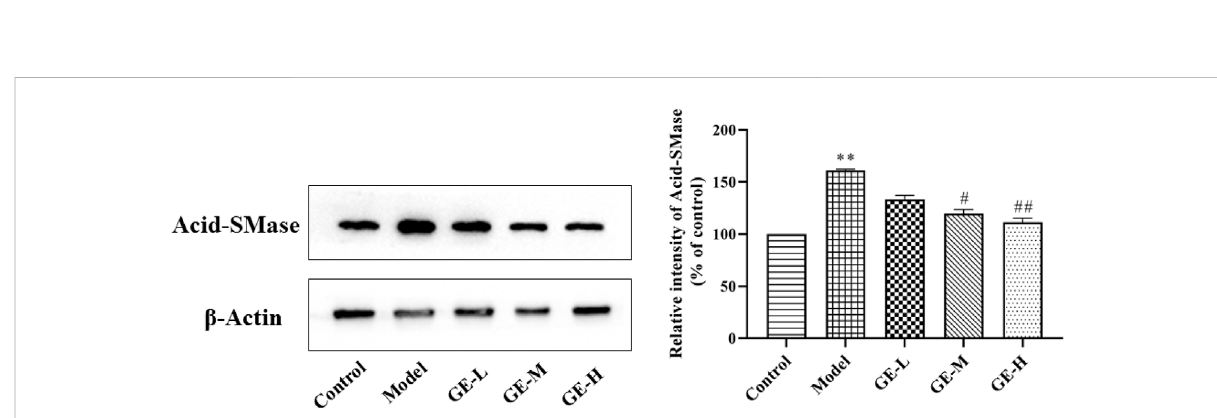
FIGURE 9 Effect of GE on the expression of Acid-SMase in the synovial tissue of AA rats. The dates are represented as mean ± SD ( n = 3) * p < 0.05, ** p < 0.01comparedtothecontrolgroup; # p < 0.05, ## p < 0.01 # comparedtothemodelgroup,GE-L=GE(30 mg/kg/day,ig),GE-M=GE(60 mg/kg/day, ig), GE-H = GE (120 mg/kg/day,